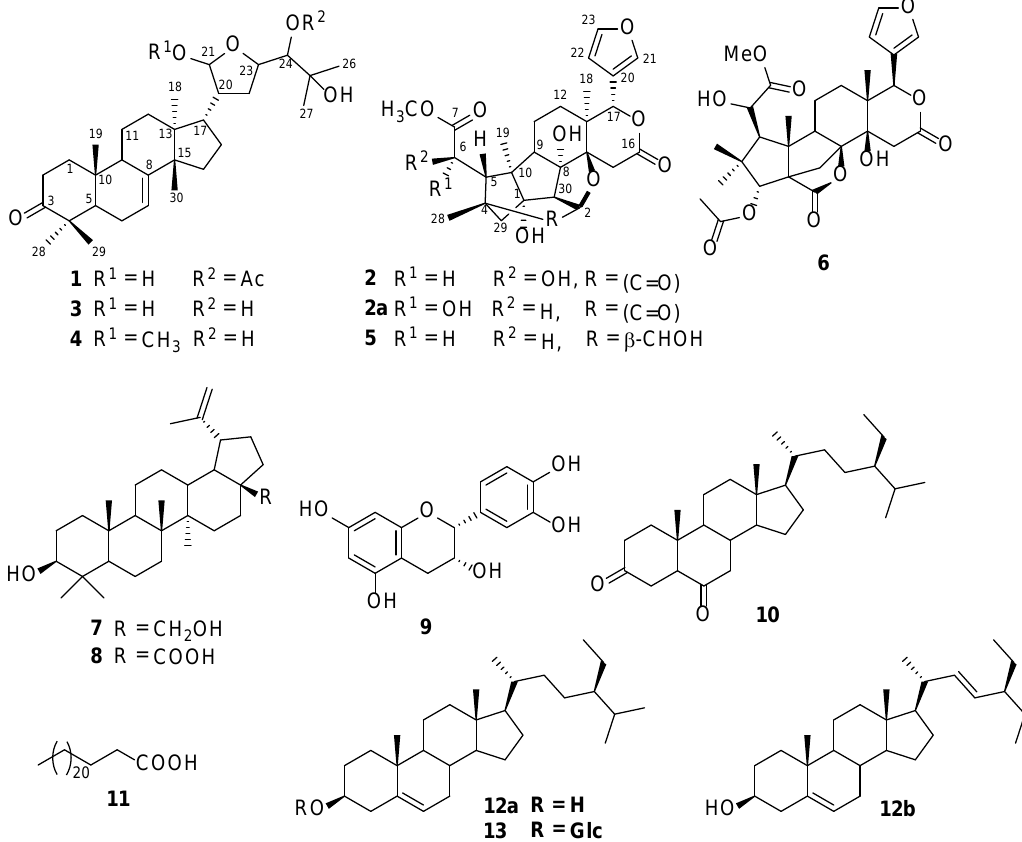
Figure 1. Structures of isolated compounds 1 – 13.